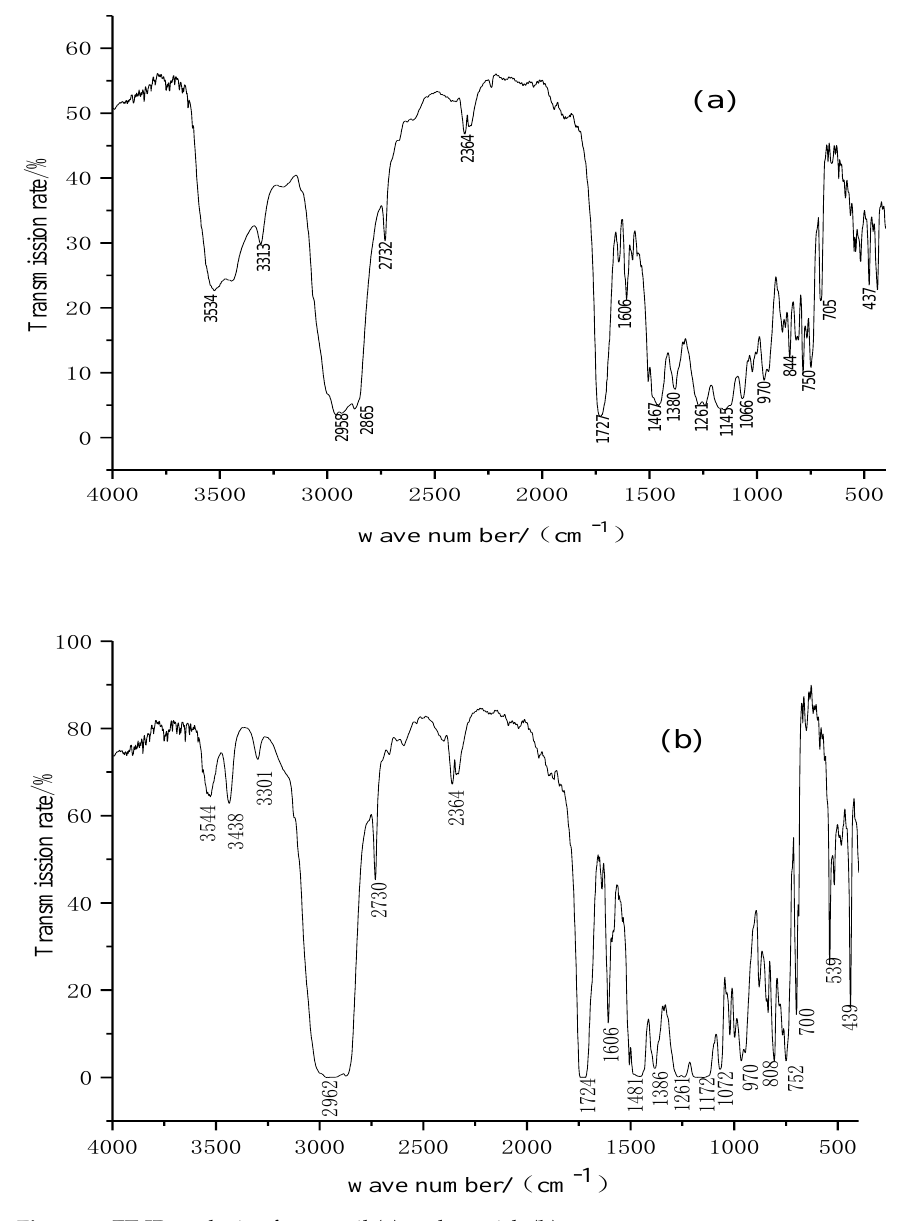
Figure 3. FT-IR analysis of cover oil ( a ) and varnish ( b ).